Question: What form of chart is displayed?
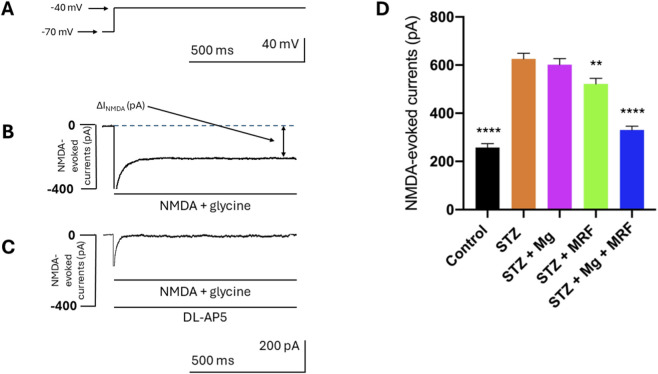
Answer: bar